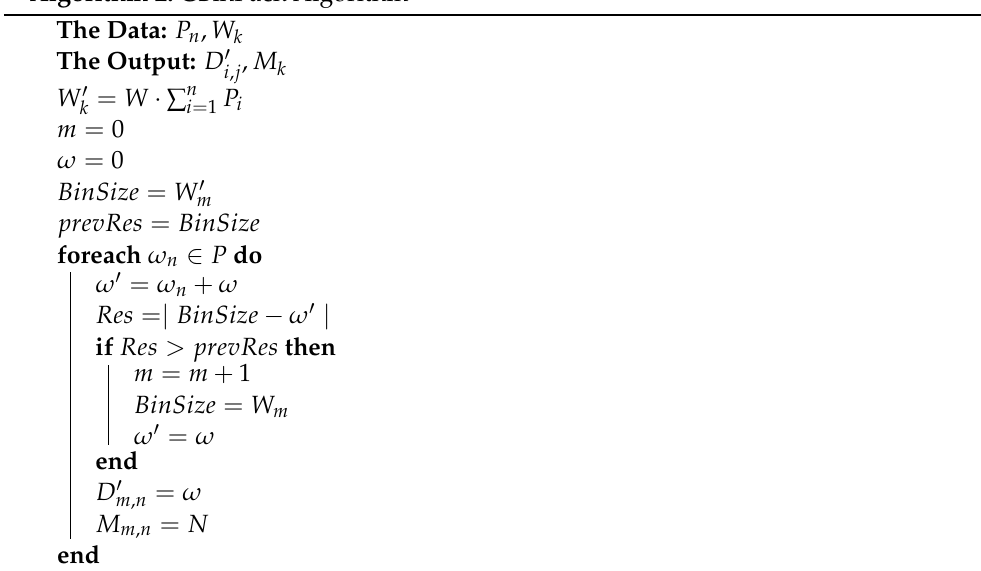
Algorithm 2: CBinPack